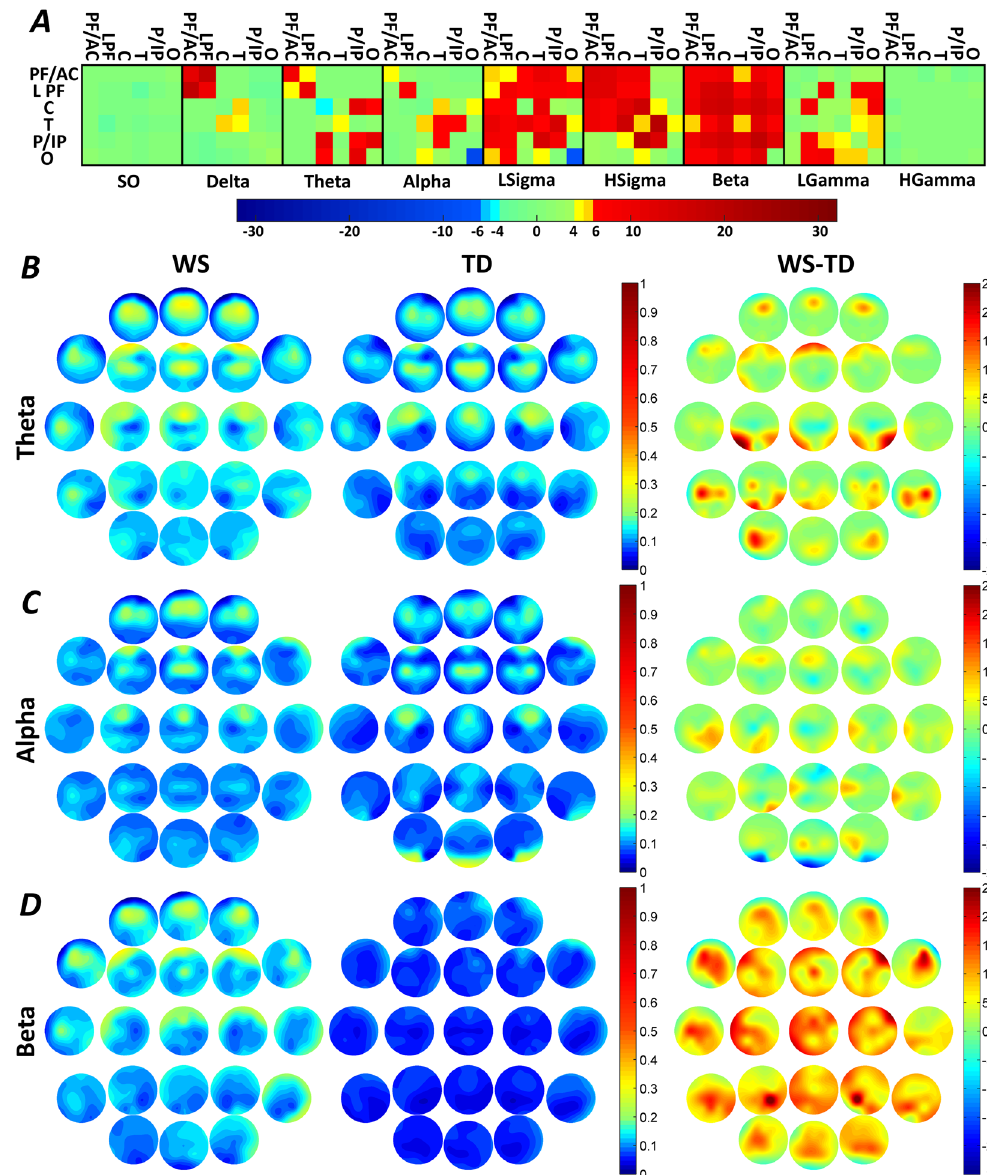
inter-regional REM sleep EEG alpha WPLI means were found in Williams syndrome subjects in spite of a parallel decrease in intra-regional O decrease as reported above. The high sigma WPLI values indicated a uniform overconnectivity, supported by the significantly increased values of the Williams syndrome group in several regions (PF/AC, LPF, C and P/IP), as well as inter-regional rela- tionships (PF/AC-LPF, PF/AC-C, PF/AC-T, LPF-C, LPF-T, T-C, T-P/IP). Uniform Williams syndrome-specific overconnectivity was indicated by the results of the analyses of REM sleep EEG beta WPLI means.